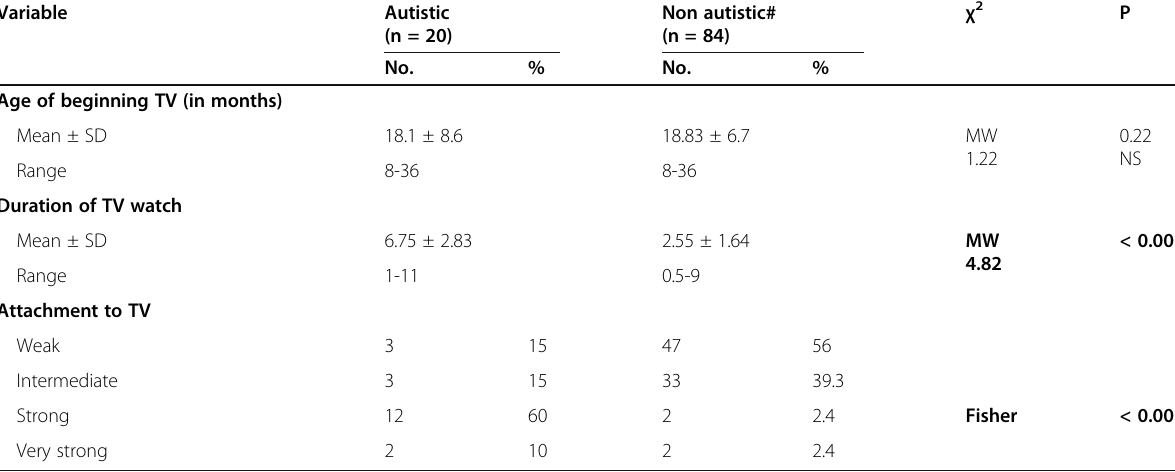
Table 5 Comparison between autistic and non-autistic children in watching TV